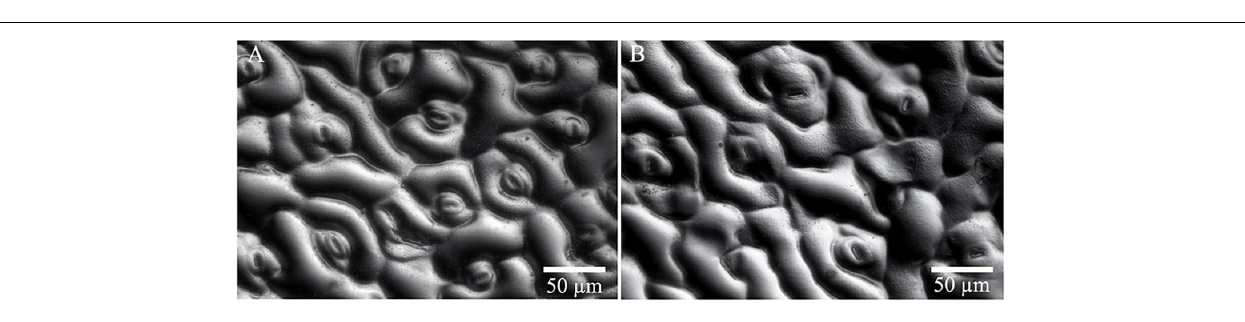
FIGURE 9 | Stomata characteristics of diploid and tetraploid leaves of Magnolia officinalis . Nail polish impressions showing stomata on the abaxial surface of diploid (A) and tetraploid (B) leaves.